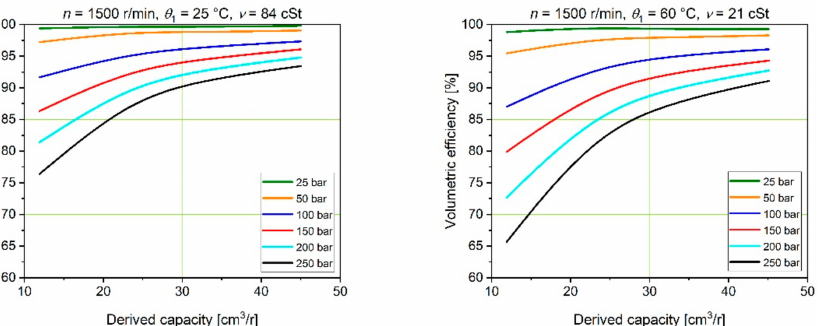
Figure 14. Volumetric efficiency of an axial piston pump as a function of derived capacity with six constant pressures. The four-calculation-point efficiency curves have been smoothed with B-splines.